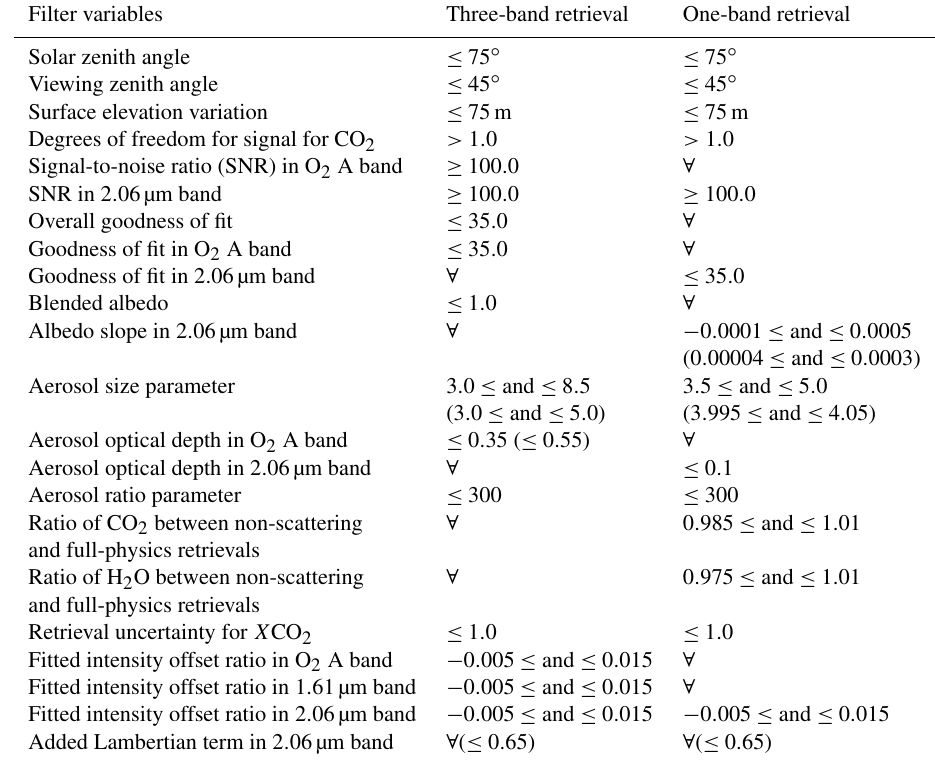
Table 2. Filter variables applied to reject low-quality X CO 2 retrievals over land and ocean in three-band and one-band retrievals. For most variables, ocean glint retrievals have the same filtering criteria as those over land. However, due to ocean glint’s unique viewing geometry and different surface properties, aerosol- and surface-related filtering variables have different ranges and are listed separately in brackets. Filter variables not used in the relevant retrieval type are marked with a ∀ sign. The blended albedo can be derived using surface albedos in the O 2 A band ( A 0 . 76 ) and 2 . 06µm band ( A 2 . 06 ) by 2 . 4 A 0 . 76 –1 . 13 A 2 . 06 (Wunch et al., 2011). The aerosol ratio parameter is calculated with the three retrieved aerosol parameters by τ ∗ z/α